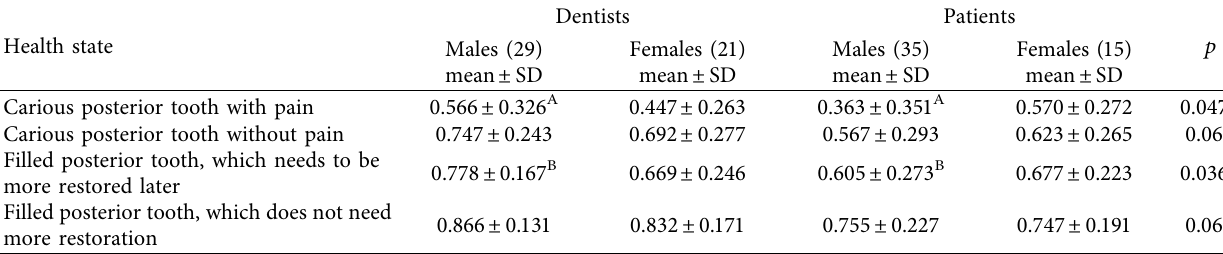
Table 3: Comparison of dentists and patients by